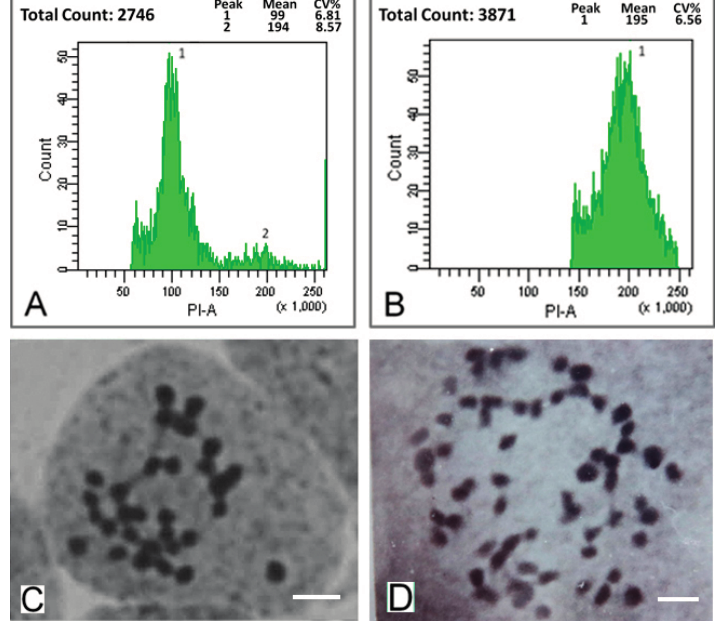
Figure 1. Ploidy analysis of mulberry leaves. ( A ) DNA content of diploids (the main peak is at channel 100); ( B ) DNA content of autotetraploids (the main peak is at channel 200); ( C ) Chromosome number in diploids (2 n = 2 x = 28). Bars = 5 μ m; and ( D ) Chromosome number in autotetraploids (2 n = 4 x = 56). Bars = 5 μ